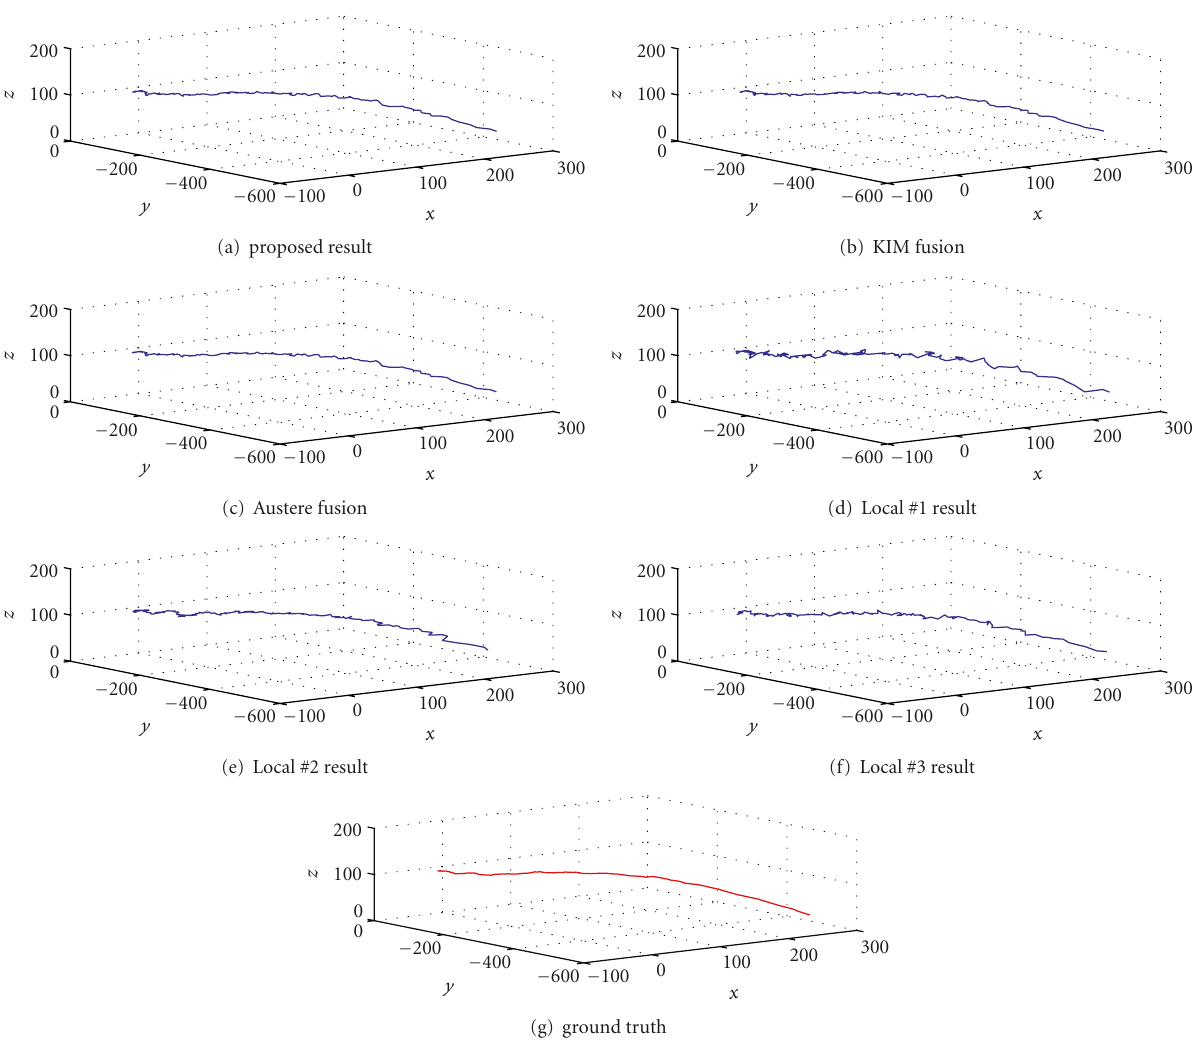
Figure 9: 3D tracking results for sequence 3. (a) Global estimate, (b) Kim’s fusion, (c) Austere’s fusion, (d)–(f) local estimates, (g) Ground